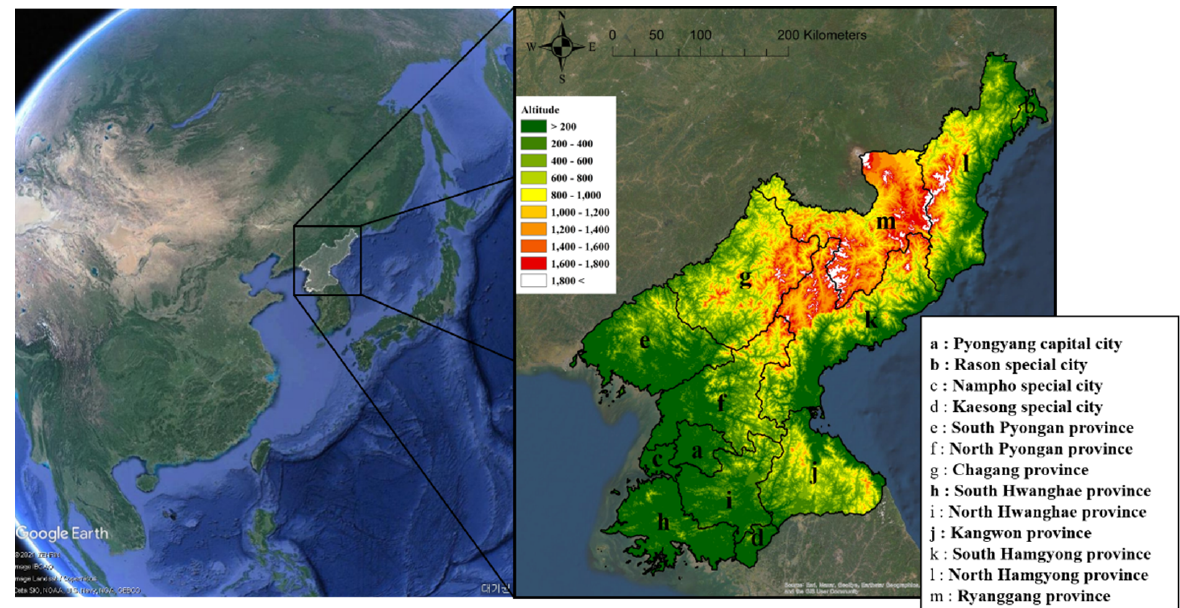
Figure 1. Study area: the administrative boundaries and elevations in North Korea.